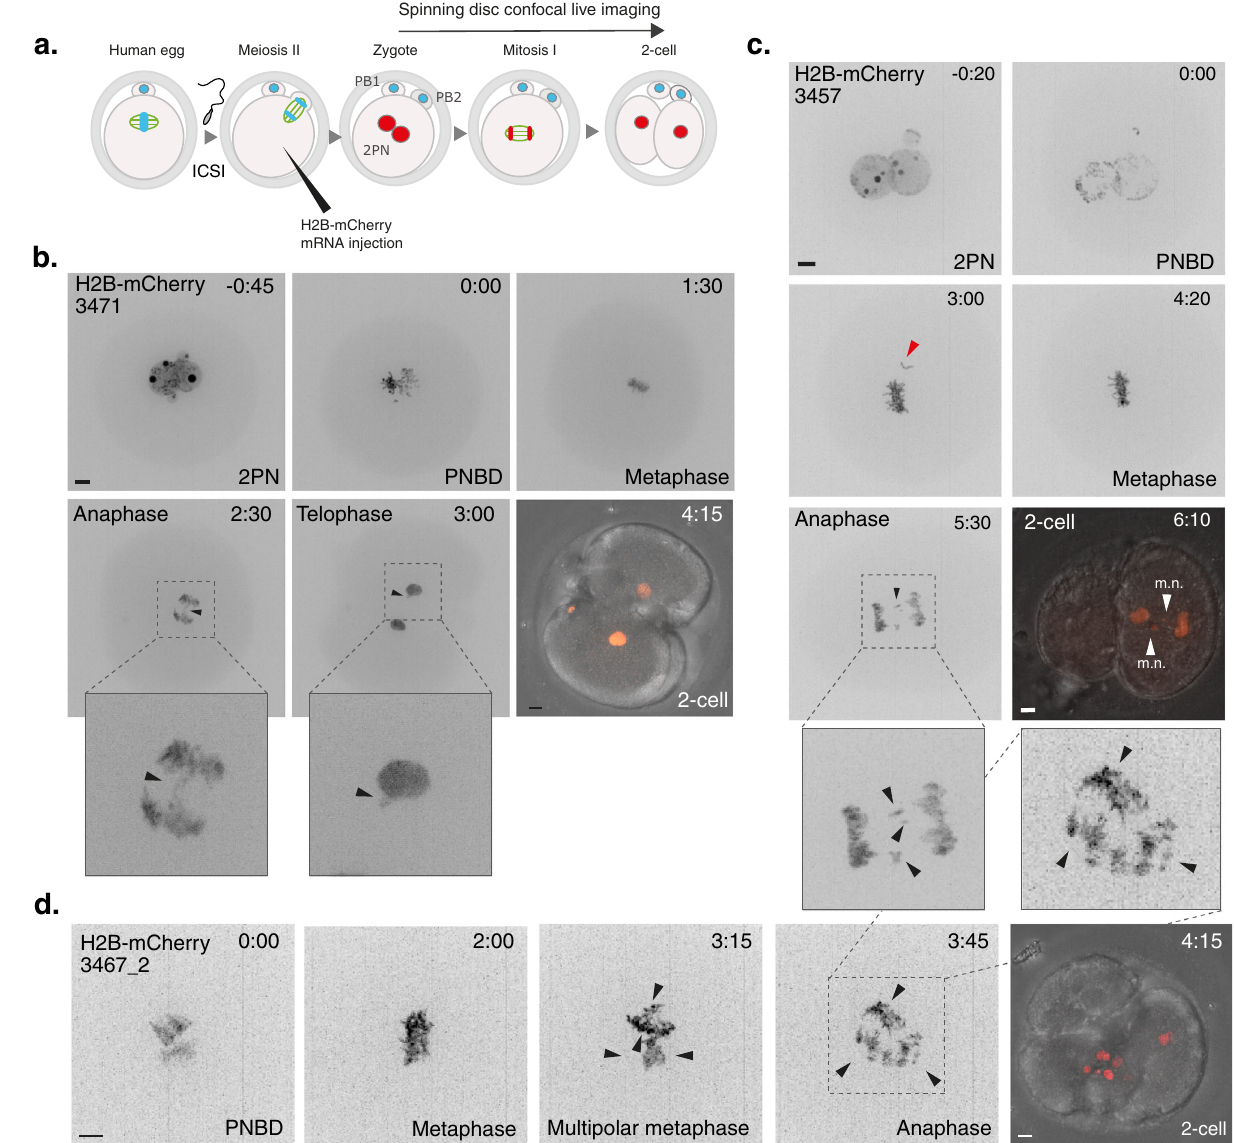
Fig. 3 | mRNA injected human embryos show errors consistent with SiR-DNA treatment. a Schematic illustrating key steps for mRNA injection into human 0PN embryos. b Time lapse imaging of embryo 3471 progressing through the fi rst mitotic division following mRNA injection. Chromosomes are visualised by H2B- mCherry expression. Scale bar 10 µ m, time in hours:mins. H2B-mCherry intensity formergedimageisvisualisedinanon-linearfashionforillustrationpurposesonly. Zoom panels and arrows show lagging chromosomes at anaphase which persist at telophase. c Same as b , embryo 3457 that progressed through the fi rst mitotic